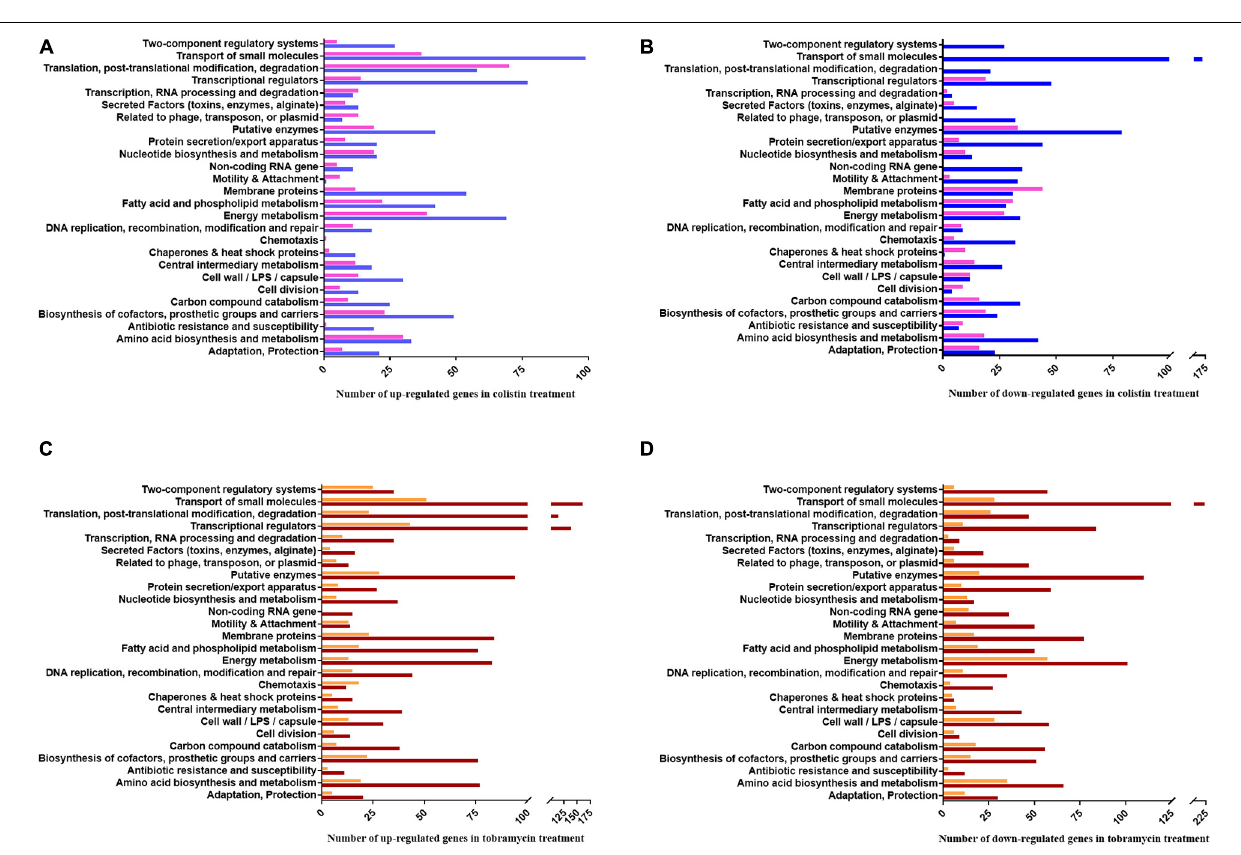
FIGURE 4 | PseudoCAP functional class distribution of annotated genes with altered expression in response to colistin or tobramycin. (A) Up-regulated and (B) down-regulated genes in colistin treated samples. Blue and pink bars indicate the number of de-regulated genes based on the RNA-seq and Ribo-seq data, respectively. (C) Up-regulated and (D) down-regulated genes in tobramycin treated samples. Brown and orange bars indicate the number of de-regulated genes based on the RNA-seq and Ribo-seq data,